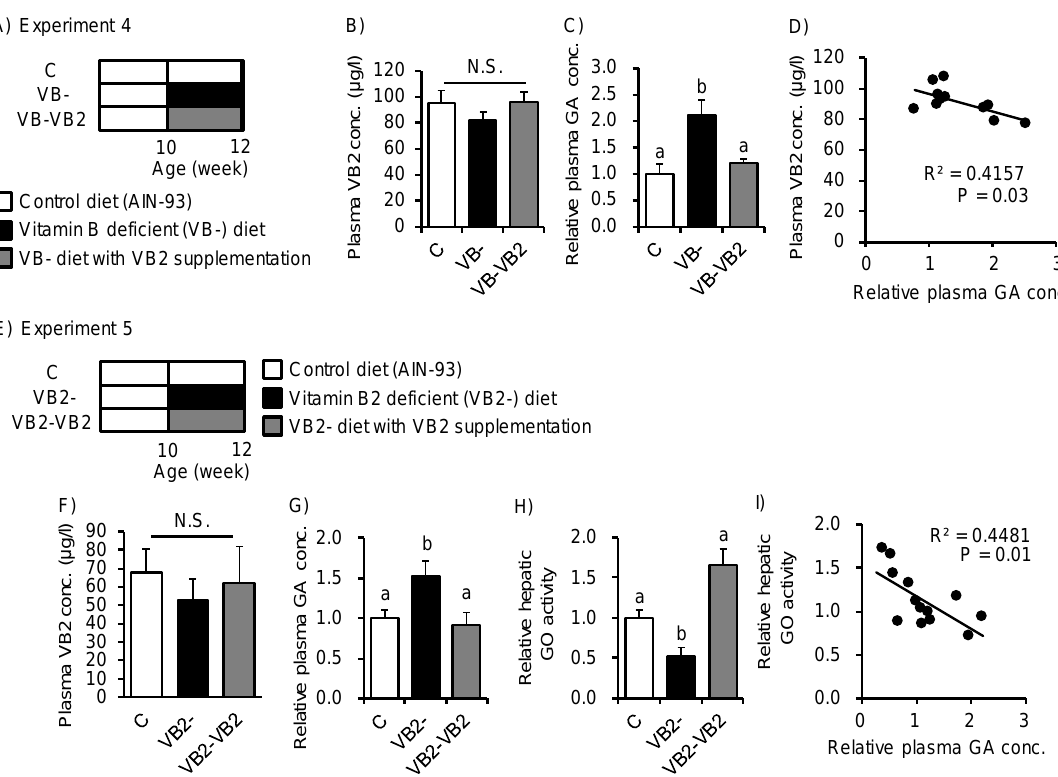
Figure 4. Feeding of a vitamin B 2 -deficient diet induced glycolate accumulation in plasma from mice. ( A , E ) Study design for Experiments 4 and 5. Mice were fed a control diet, VB- diet, or VB2-deficient (VB2-) diet for 2 weeks with or without VB2 supplementation (6 μg/mL flavin mononucleotide sodium salt solution in distilled water). ( B , F ) Average plasma VB2 concentration in each of the three groups. ( C , G ) Relative plasma concentration of GA. ( D ) Spearman’s rank correlation coefficients between plasma VB2 concentration and plasma GA levels (r 2 = 0.42, p = 0.03). ( H ) Relative GA oxidase (GO) activity in the liver. ( I ) Spearman’s rank correlation coefficients between relative hepatic GO activity and plasma GA levels (r 2 = 0.45, p = 0.01). ANOVA was used to determine differences in each group (n = 3–4 in Experiment 4 and n = 4–5 in Experiment 5). Different letters indicate p < 0.05 and N.S. represents no significant difference among the groups.